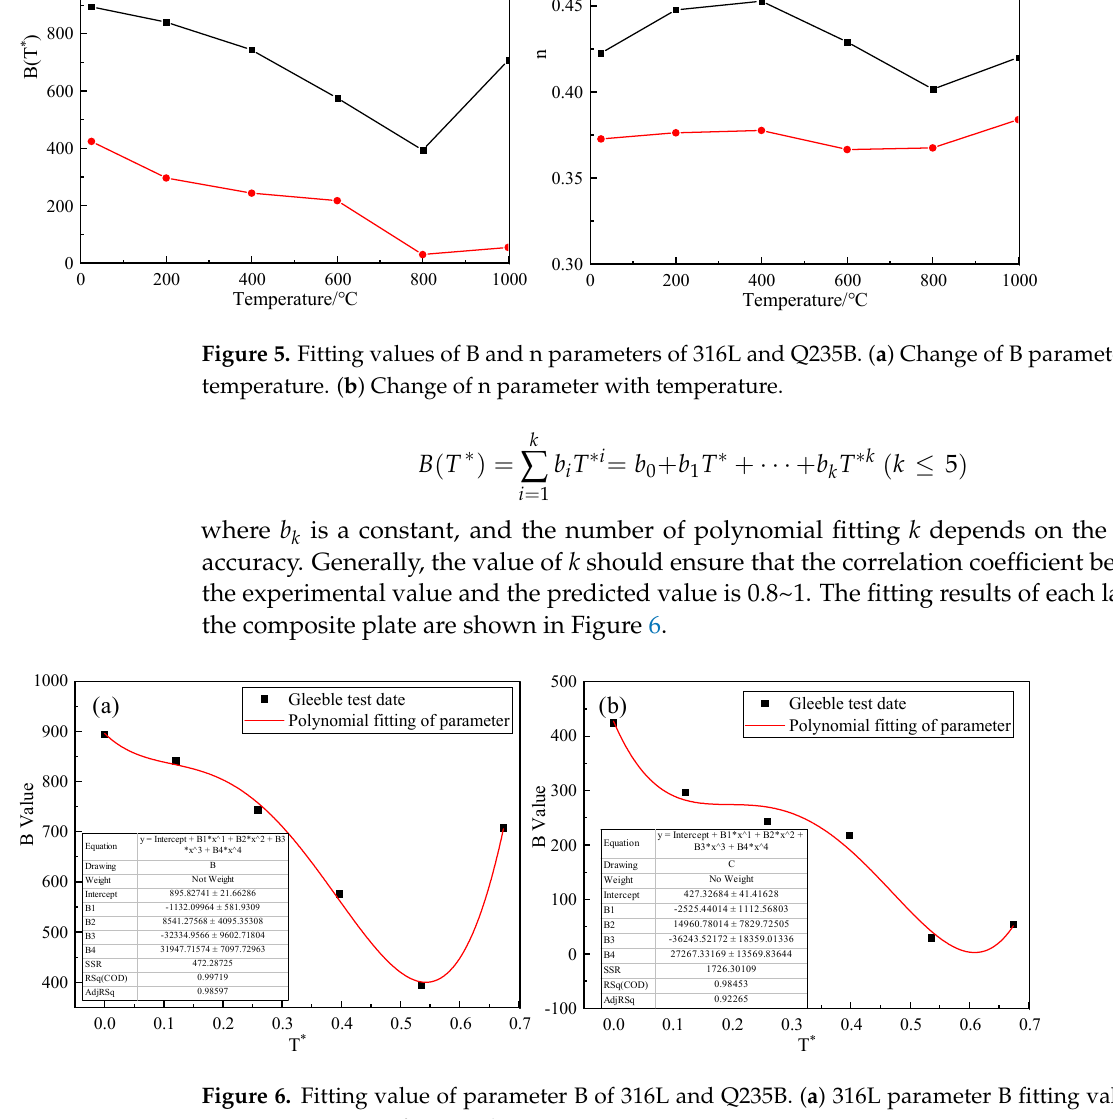
Q235B parameter B fitting value.